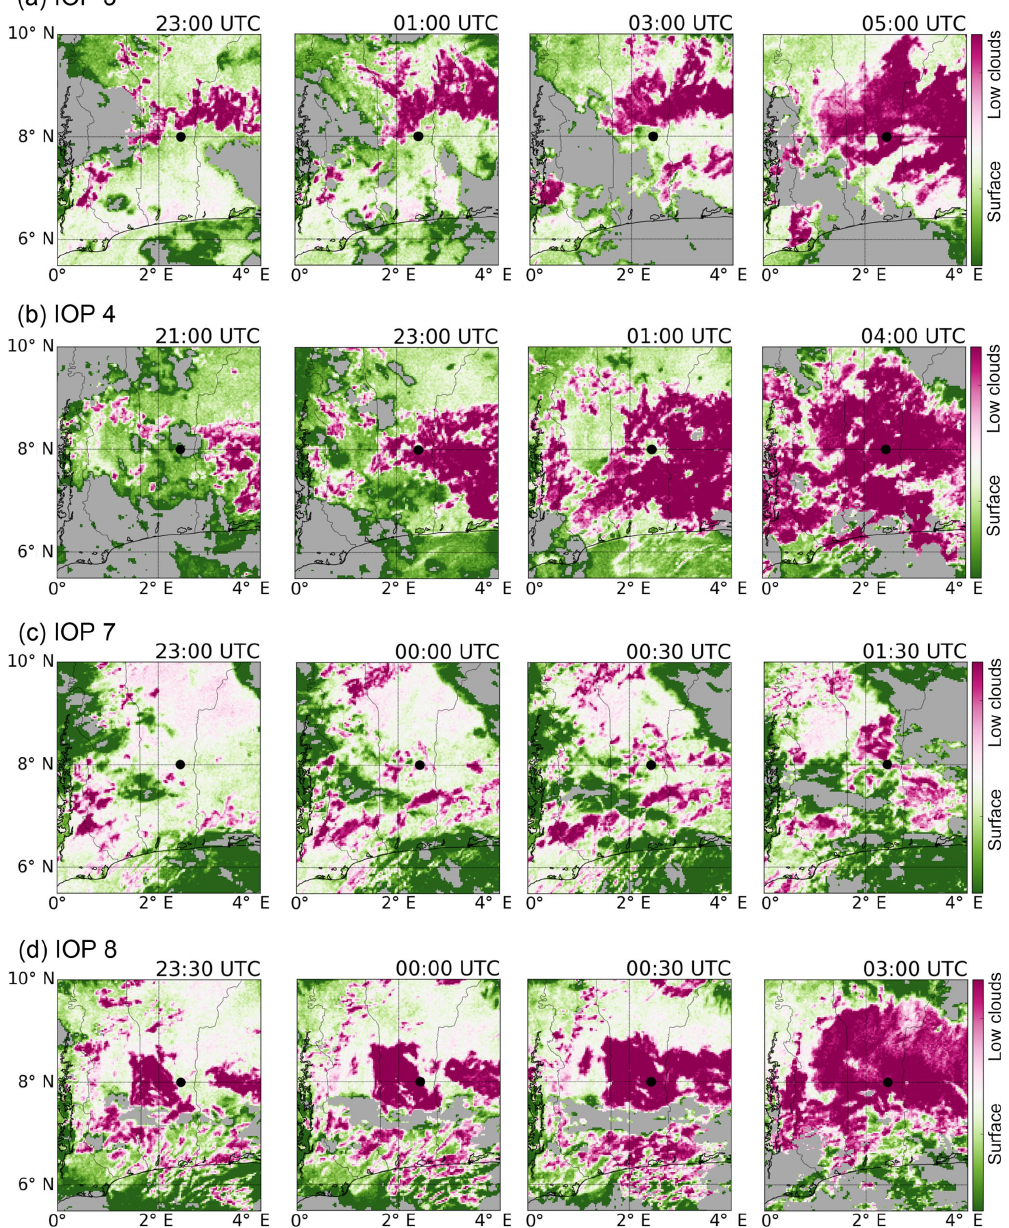
Figure 6. Brightness temperature difference of the thermal-infrared channel at 10.8 and 3.9µm for IOP 3 (a) , 4 (b) , 7 (c) and 8 (d) . Purple color indicates LLCs. The gray shading marks areas where the brightness temperature of the 10.8µm channel exceeds 283K, as an indicator for higher-level clouds. The maximum and minimum values of the color scale are 3.5 and − 1 . 0, respectively. The location of Savè is indicated by the black